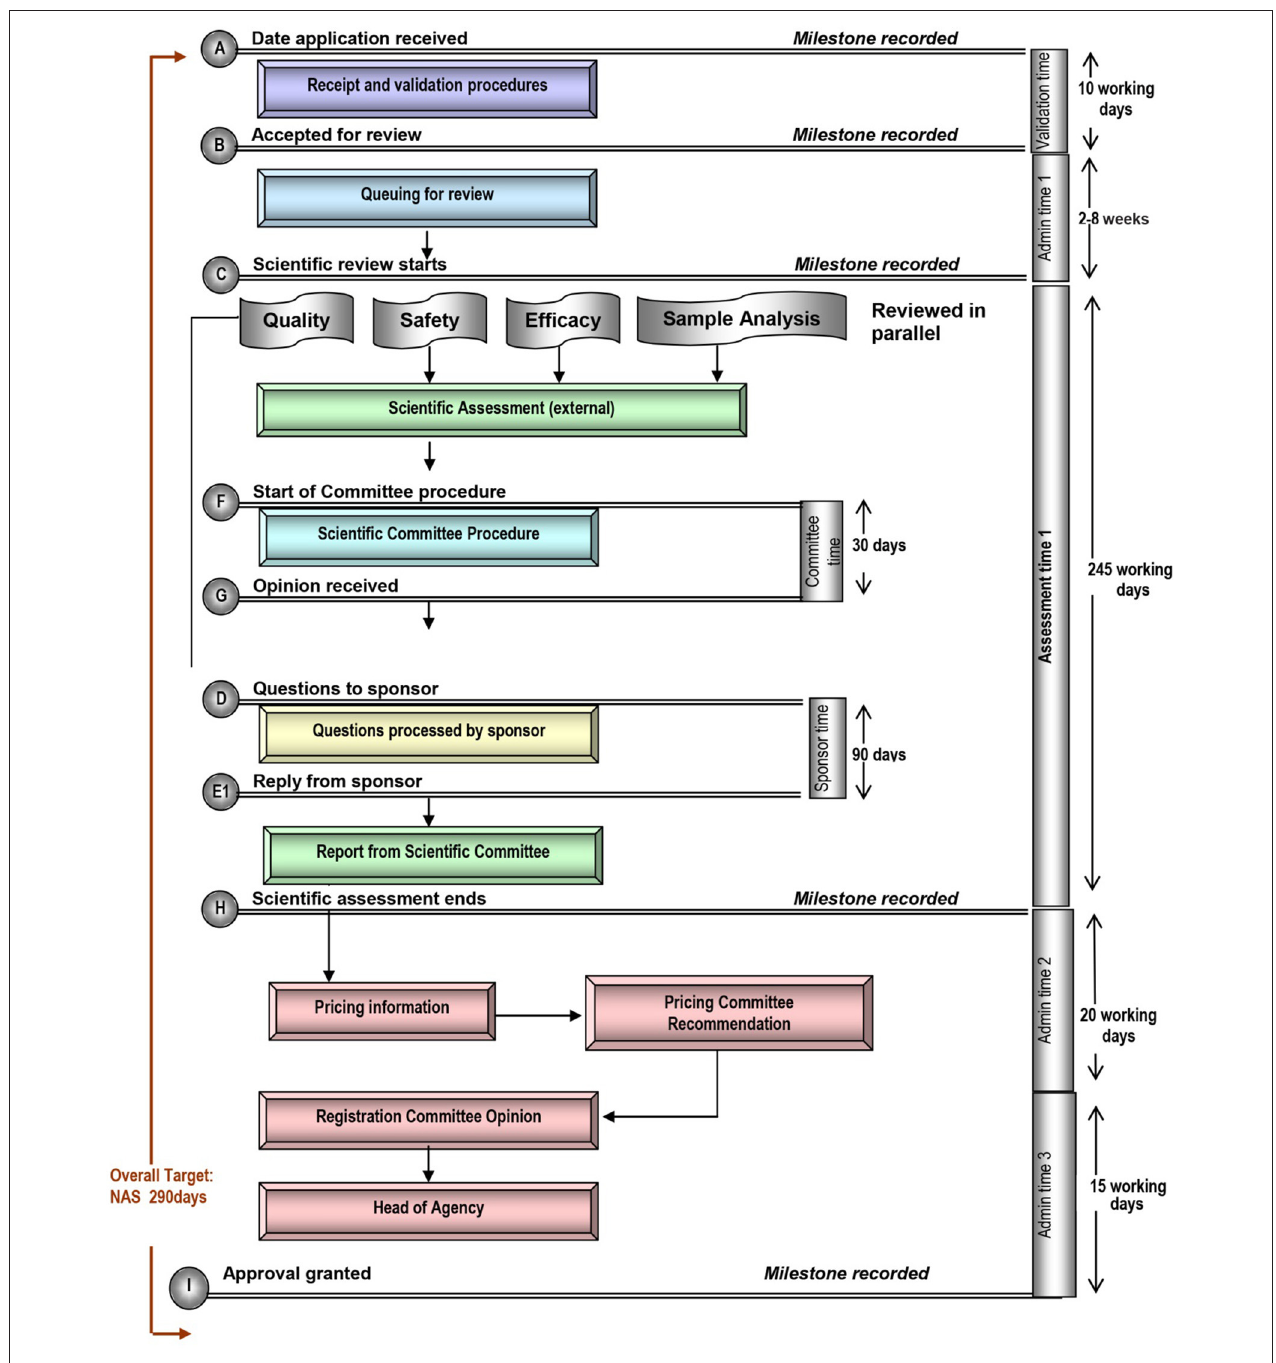
FIGURE 4 | Registration process map for Saudi